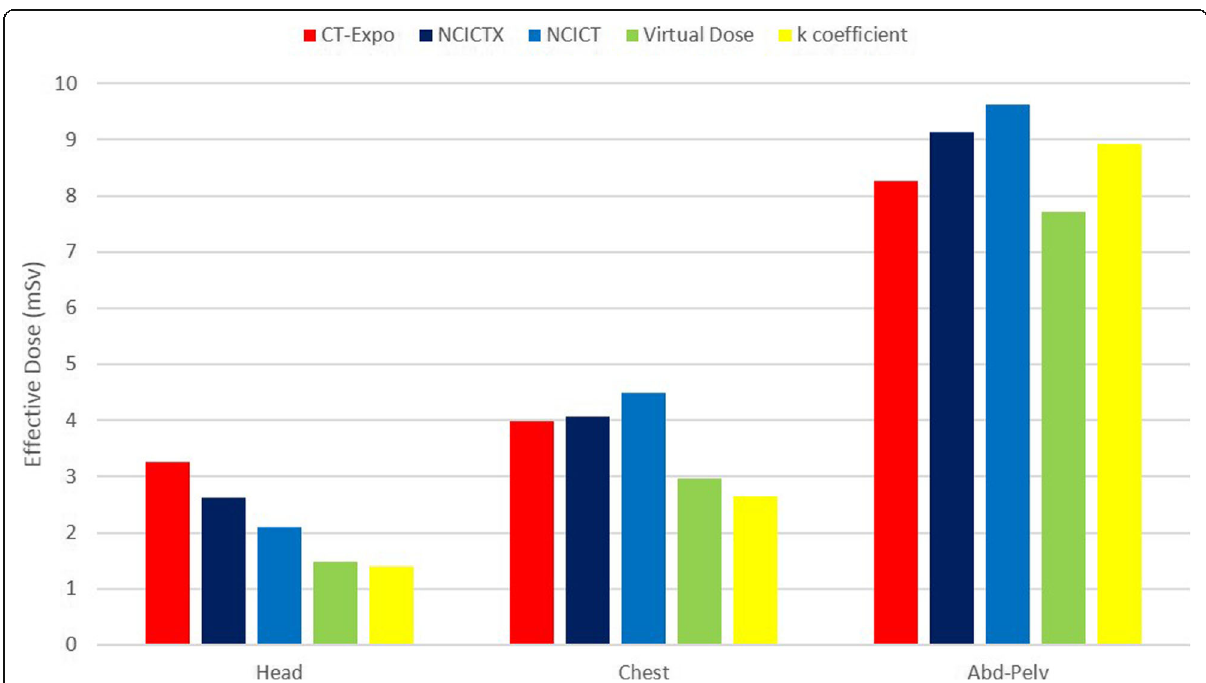
Fig. 6 Effective dose histogram. For each software application, we estimated the effective dose starting from the organ dose coefficients multiplied by the median volume computed tomography dose index (CTDI vol ) for head, chest, and abdomen-pelvis exams. The effective dose was obtained as sum of the organ doses weighted according to International Commission on Radiological Protection 103. We have added the values estimated using dose-length product conversion factors ( k